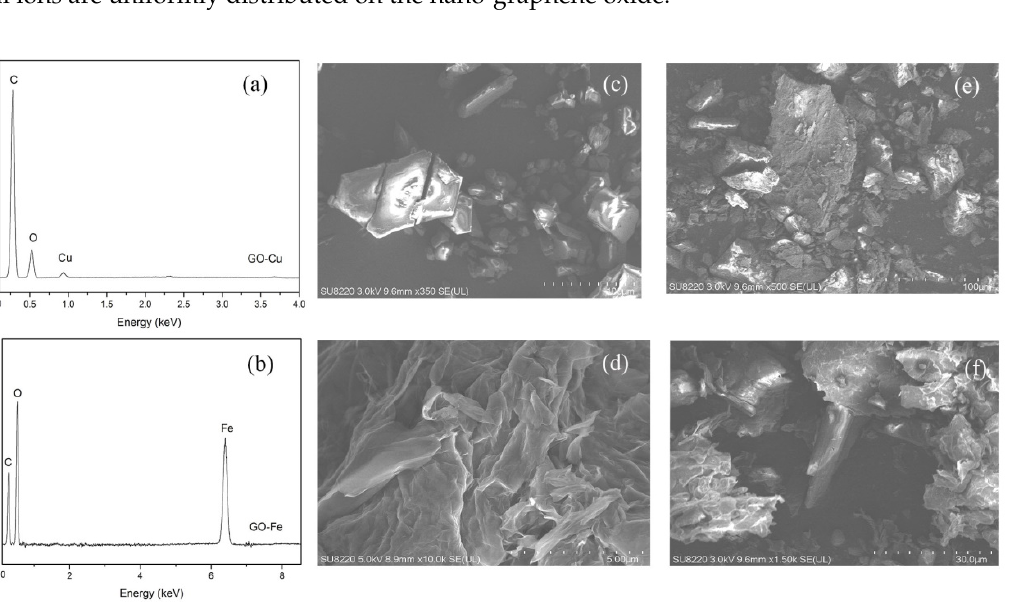
Figure 4. EDS spectra surface elemental analysis of ( a ) nGO-Cu and ( b ) nGO-Fe; SEM images of ( c ) FOX-7, ( d ) nGO, ( e ) nGO-Fe-FOX-7, ( f ) nGO-Cu-FOX-7.